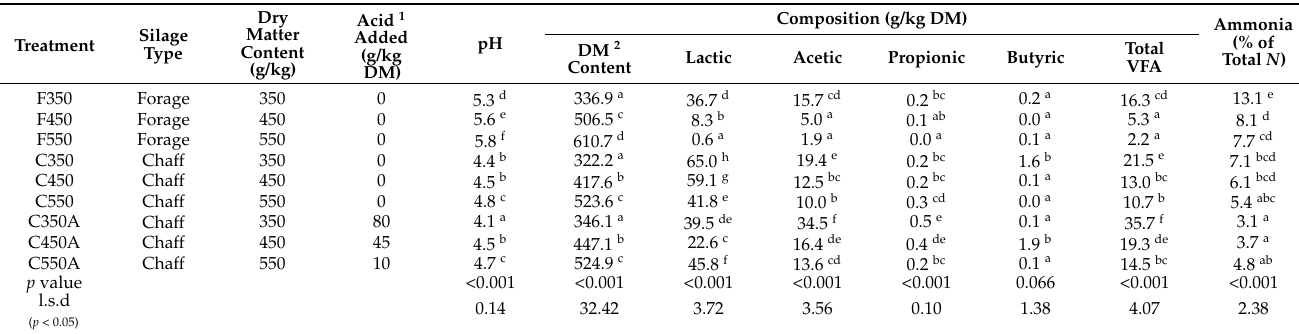
Table 3. Composition and pH of silages produced from Medicago sativa L. forage wilted to achieve different dry matter contents, or chaff with either water or water plus acid added to achieve a similar dry matter content. Treatment Forage